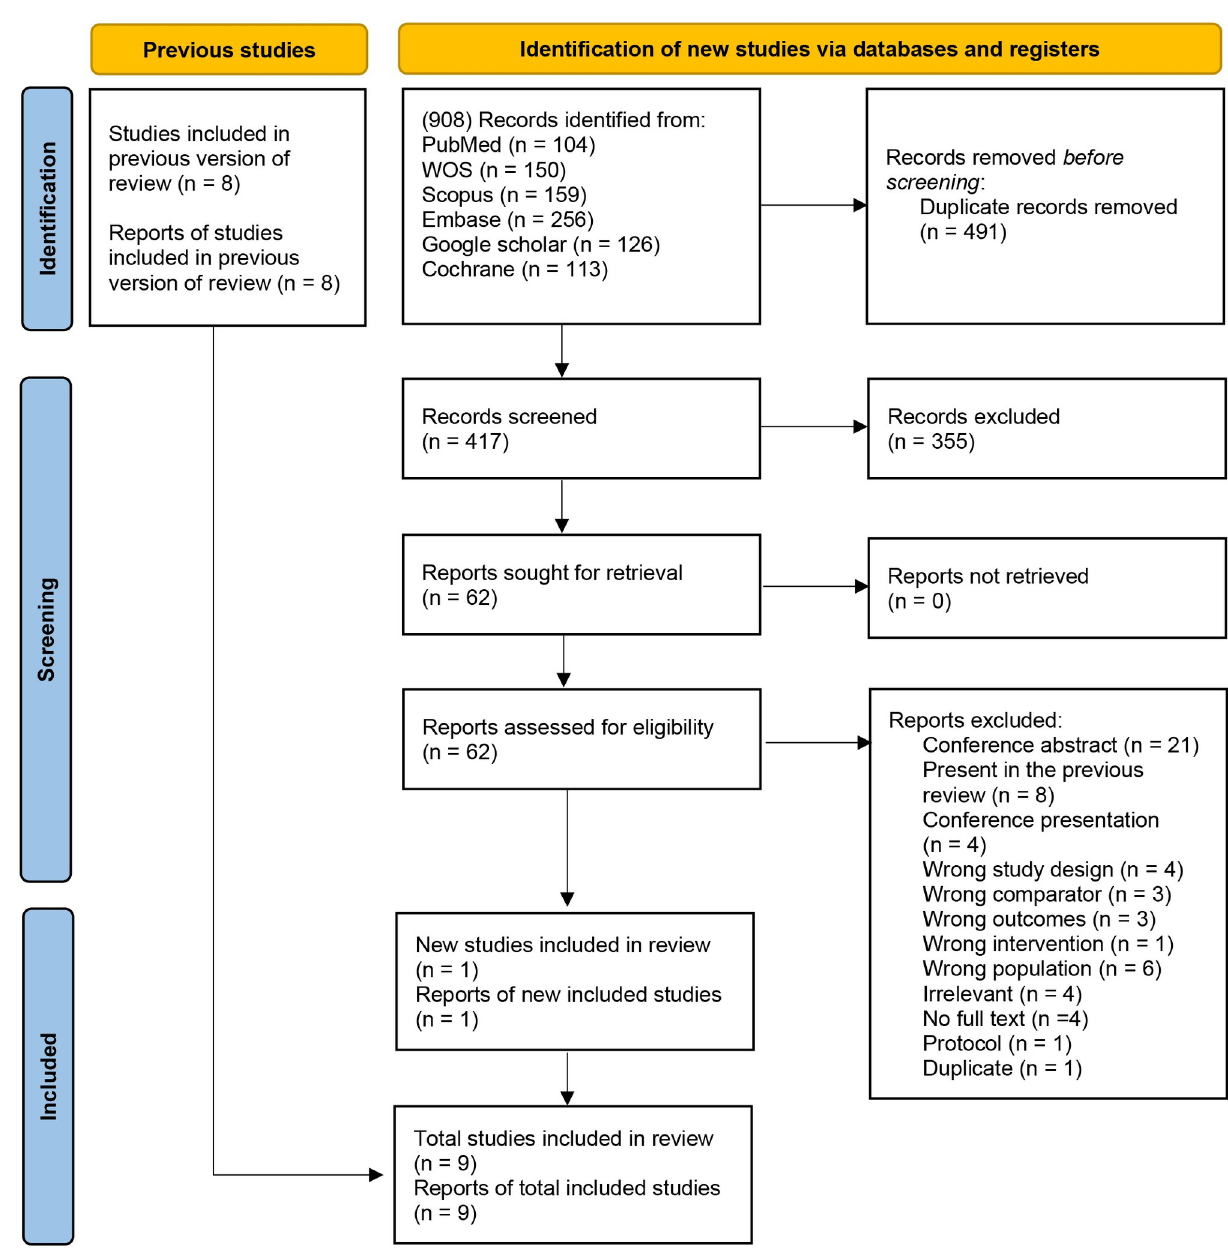
Fig 1. PRISMA 2020 flow diagram for updated systematic reviews, which included searches of databases, registers, and other sources.